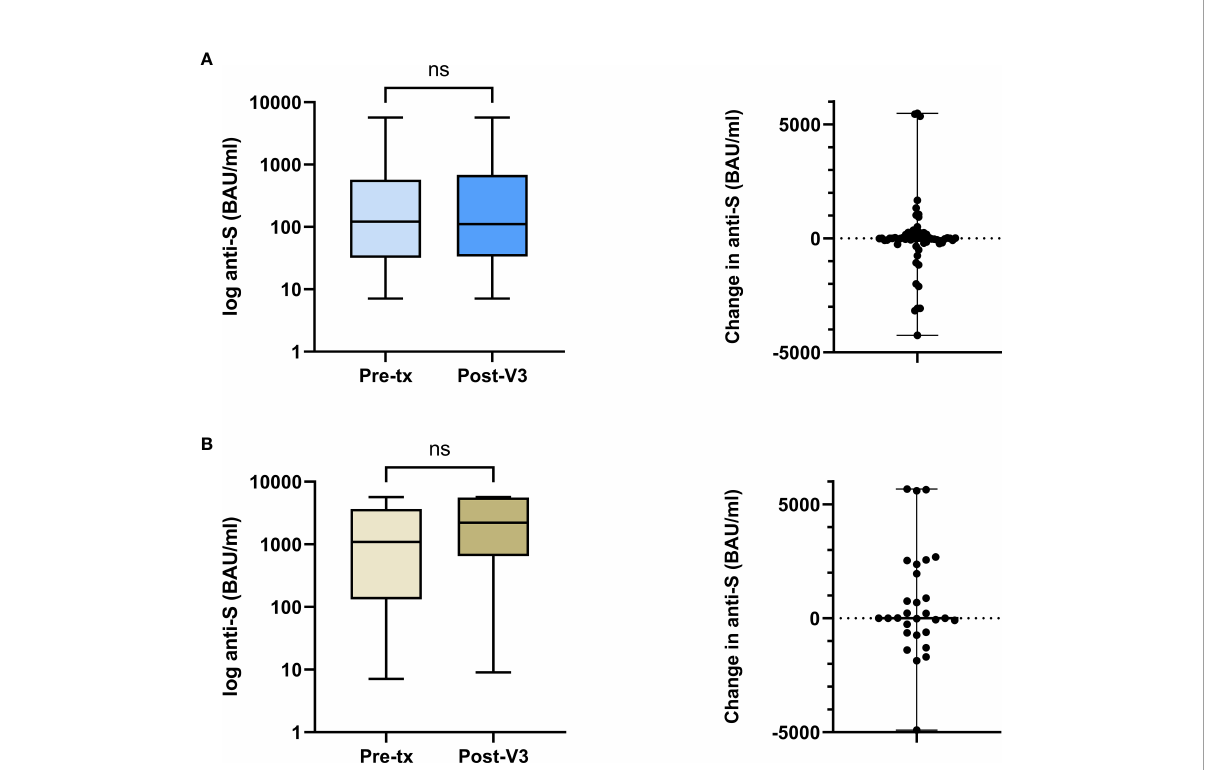
FIGURE 2 Comparison between pre-transplant and post-V3 anti-S concentrations in the V2-cohort by prior infection exposure. (A) In infection naïve patients, the median anti-S pre-transplant and post-V3 did not change, 122 (32-574) and 111 (34-682) BAU/ml respectively, with a median difference of -1 (-182-153) BAU/ml, p=0.78. (B) In patients with prior infection, the median anti-S pre-transplant and post-V3 did not change, 1090 (133-3667) and 2207 (650-5618) BAU/ml respectively, with a median difference of 4 (-625-2160) BAU/ml, p=0.26. ns, non-signi fi